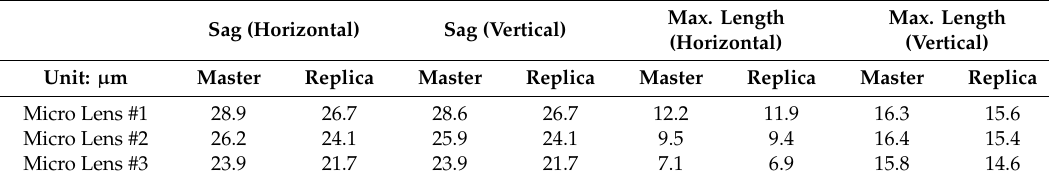
Figure 2. Measurement images of the master mold and imprinted single lens obtained with a micro 3D profiler. Scale bar: 20 µm. Table 1. Measurement data for sag and size of single lenses.